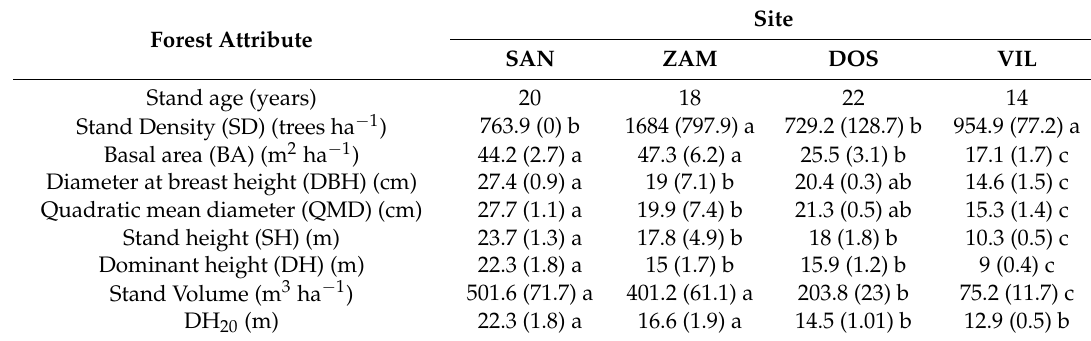
Table 5. Structural attributes of pine ( Pinus patula ) forest stands (DOS: Dos Puentes, SAN: Santiago, VIL: Villonaco, ZAM: Zamora-Huayco). Forest Attribute